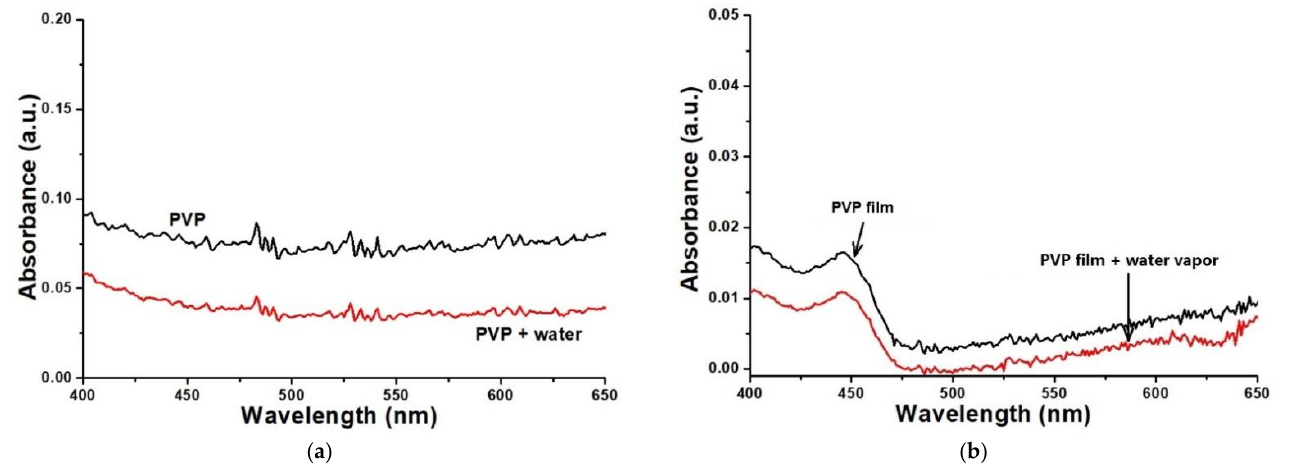
Figure 4. Variation of PVP ethanol solution ( a ) and PVP film ( b ) absorption